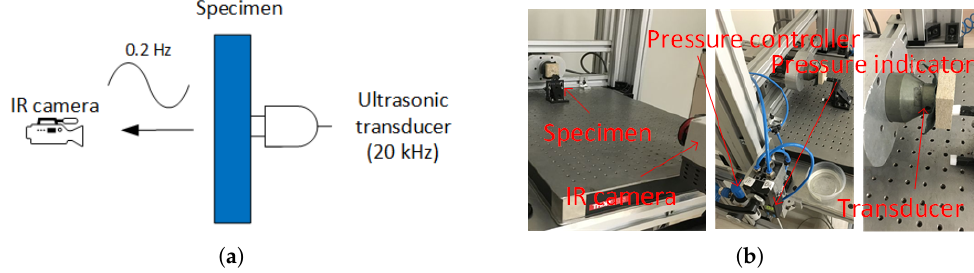
Figure 5. VT configurations: ( a ) schematic set-up; ( b ) experimental